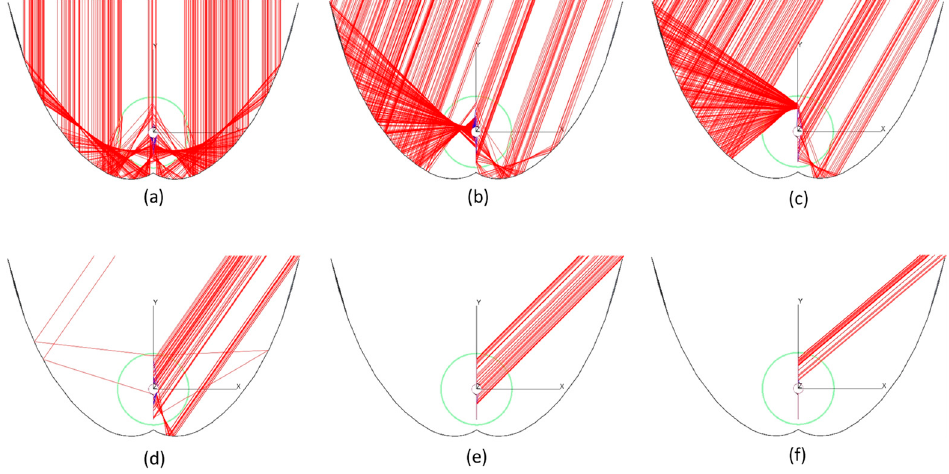
Figure 9. Ray tracing diagrams in case of 60% truncated CPC coupled with CT receiver for different incidence angles: ( a ) 0°; ( b ) 20°; ( c ) 30°; ( d ) 35°; ( e ) 45°; ( f ) 50°.